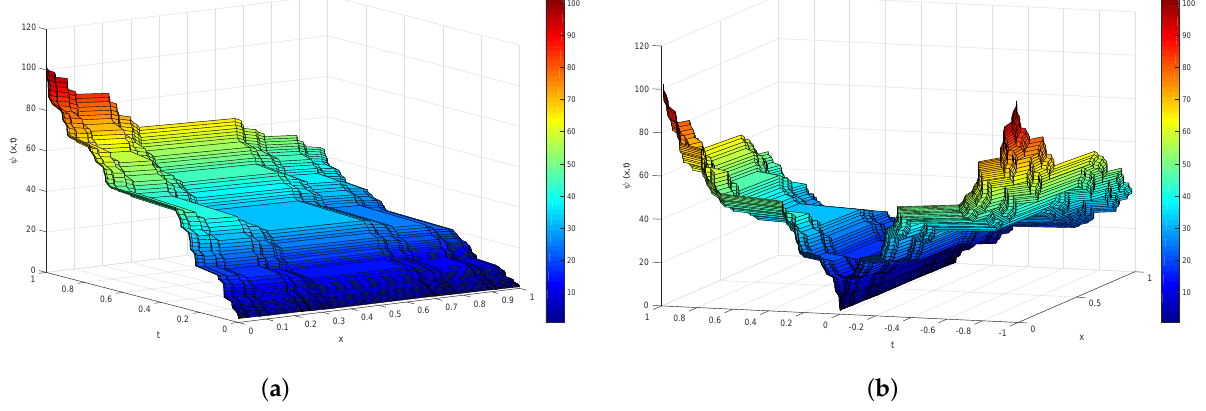
Figure 1. In the case of ψ ( x , t ) solution in the local fractional sine-Gordon equations, by choosing A = 1, k = 1, c = 1, δ = 1. ( a ) 0 ≤ t ≤ 1; ( b ) − 1 ≤ t ≤